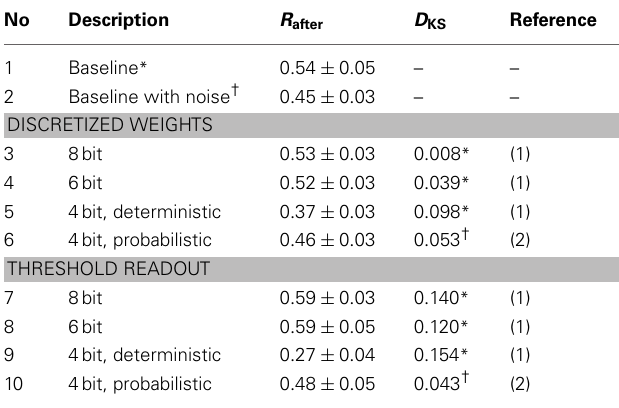
The table lists the final performance R after and the Kolmogorov–Smirnov (KS) measure D KS comparing the final weight distribution to the one of the reference simulation indicated by its row number in the last column. For this comparison, the continuous reference distribution is rounded to the respective resolution. The p-value for the KS test is p = 0.35 for 8bit and p < 0.01 in all other